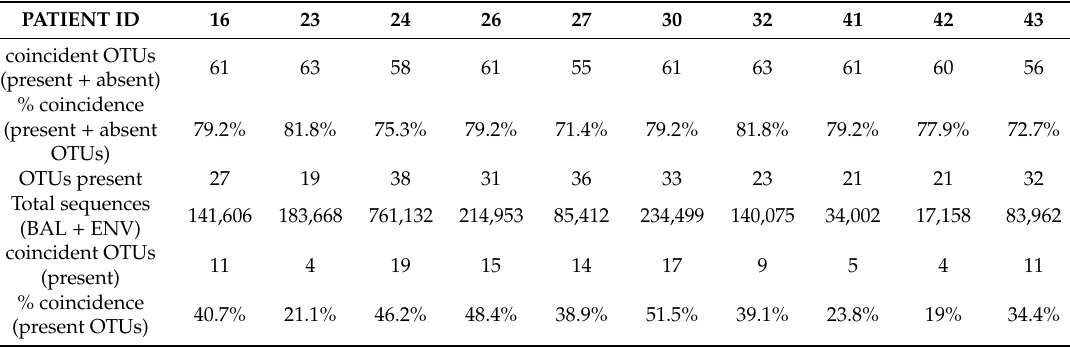
Table 6. Degree of co-occurrence of OTUs in the mycobiome of the lung and the house of 10 patients who o ff ered both kinds of